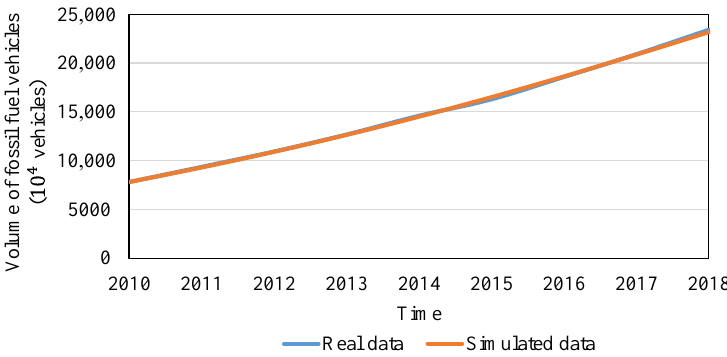
Figure 7. Compare the number of fossil fuel vehicles with real data and simulated